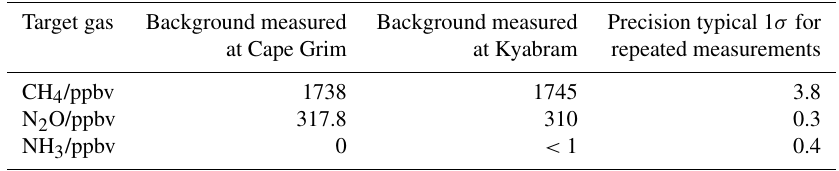
Table 5. Measurement precision and comparison with clean air composition for OP-FTIR measurements during the trace gas release trial experimental period at Kyabram. Background mole fractions measured at Cape Grim Baseline Air Pollution Station in Tasmania at the same time are also shown.